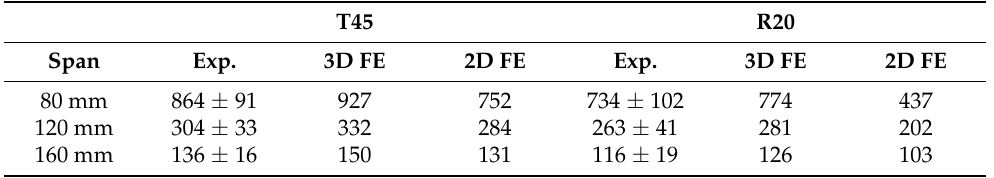
Table 7. Experimentally measured and computed stiffnesses (all in N/mm). “±” denotes standard deviation.